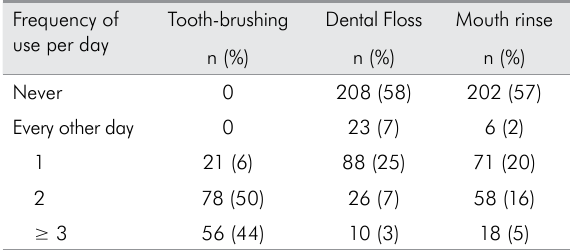
Table 1. Frequency of oral hygiene practices among